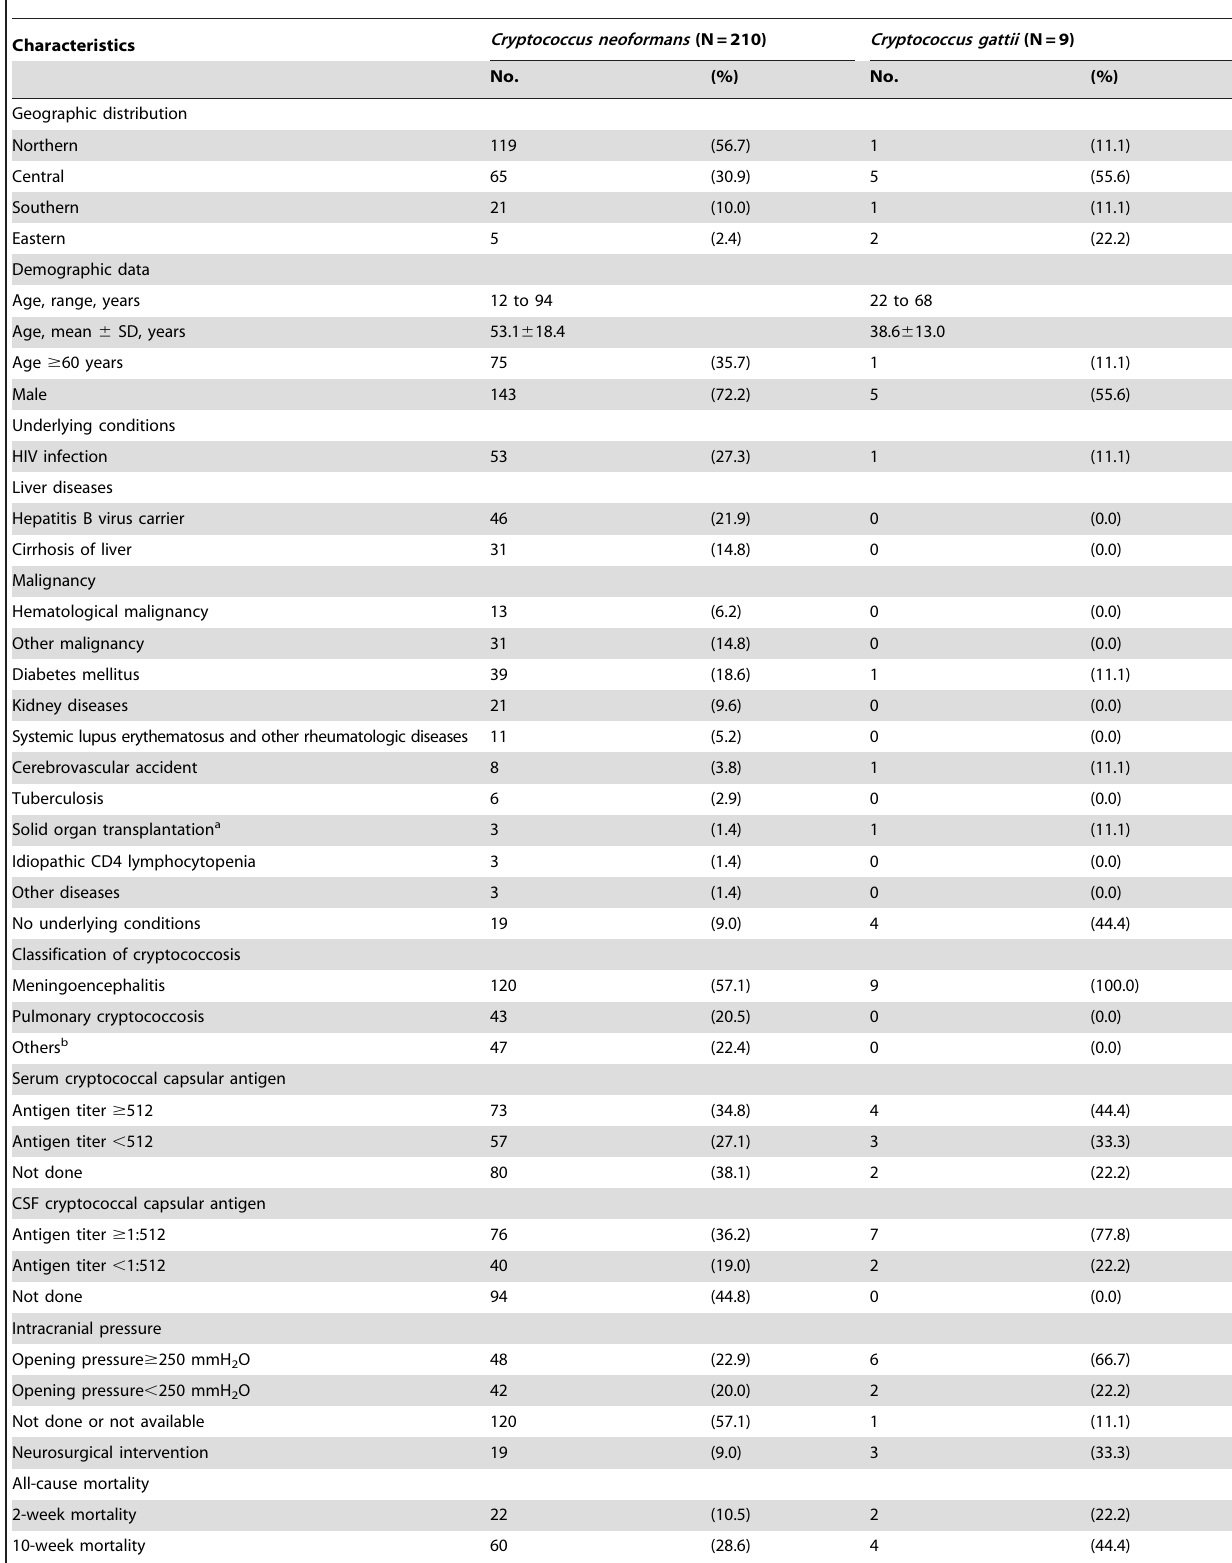
Table 2. Epidemiological and clinical characteristics of 219 patients with proven cryptococcosis hospitalized at 20 hospitals in Taiwan,